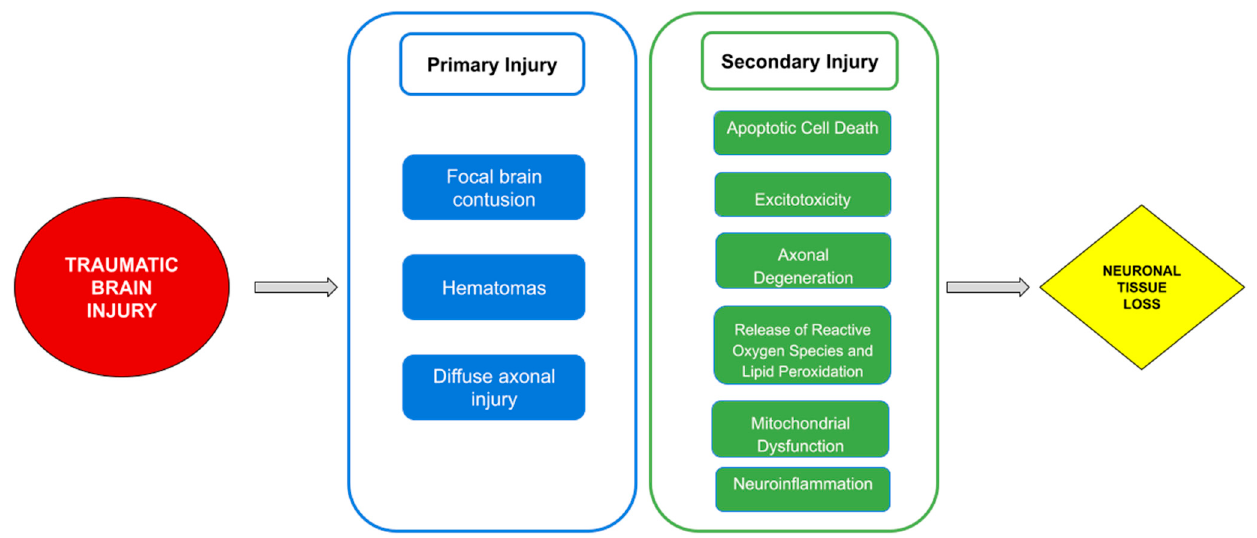
Figure 2. This figure shows the pathophysiological mechanisms of primary and secondary injury after